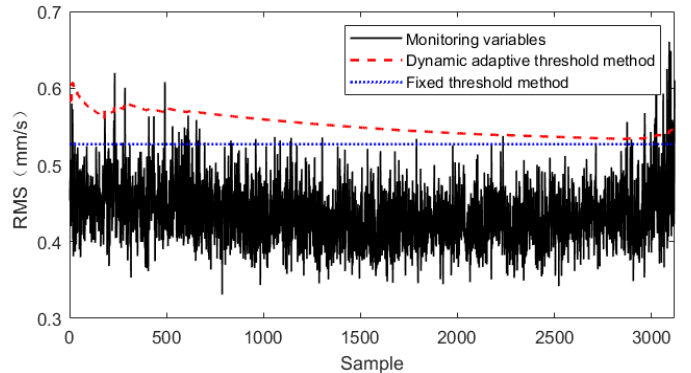
Figure 8. Adaptive dynamic alarm line in each state of the equipment.